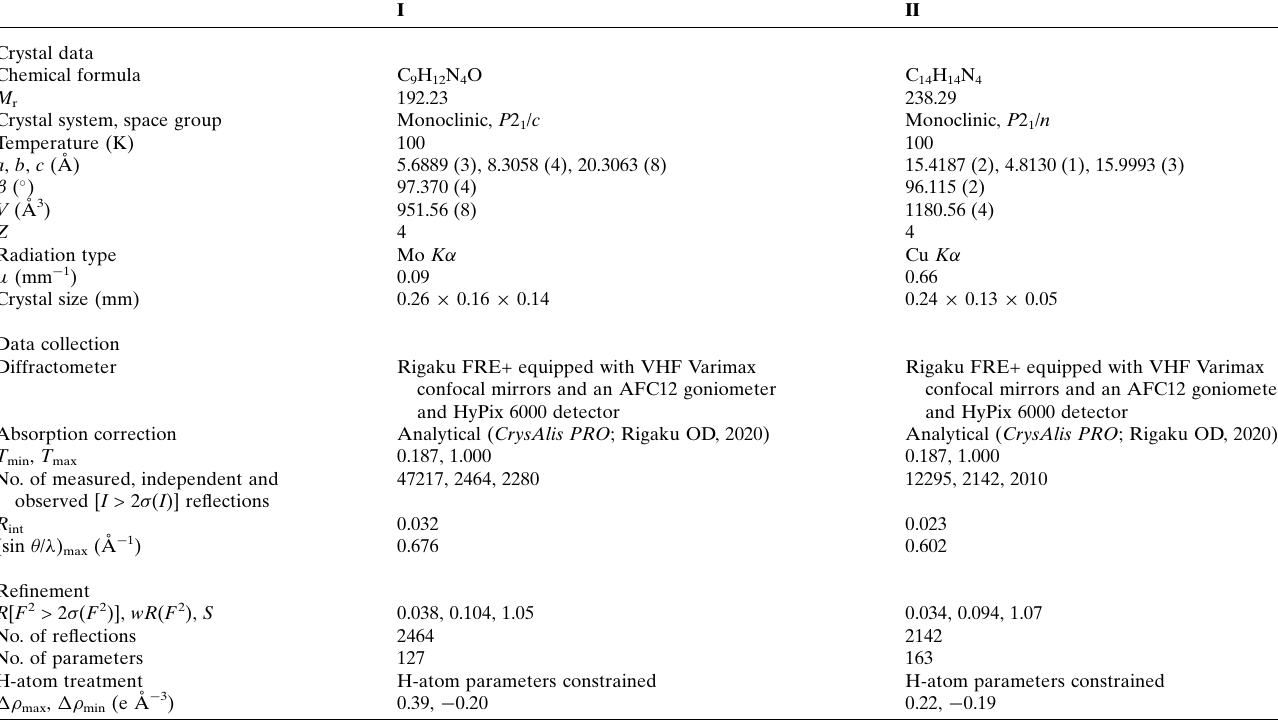
Table 3 Experimental details.